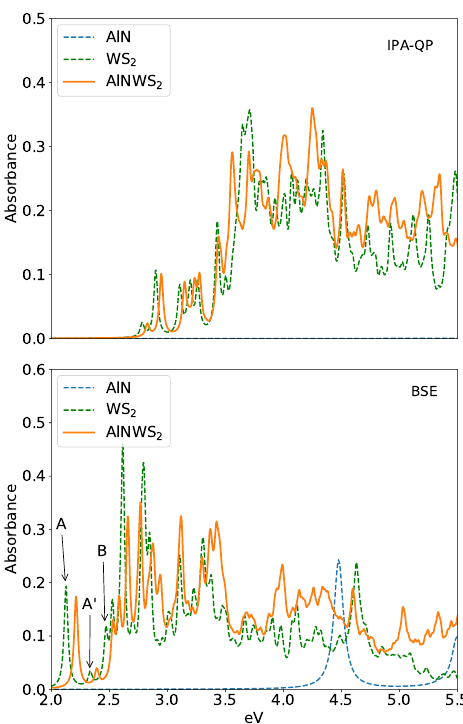
Figure 4. Absorbance of AlN / WS 2 heterostructure, and of isolated AlN and WS 2 , calculated within the independent-quasi-particle approach G 0 W 0 level ( top panel ) and Bethe–Salpeter equation ( bottom panel ).